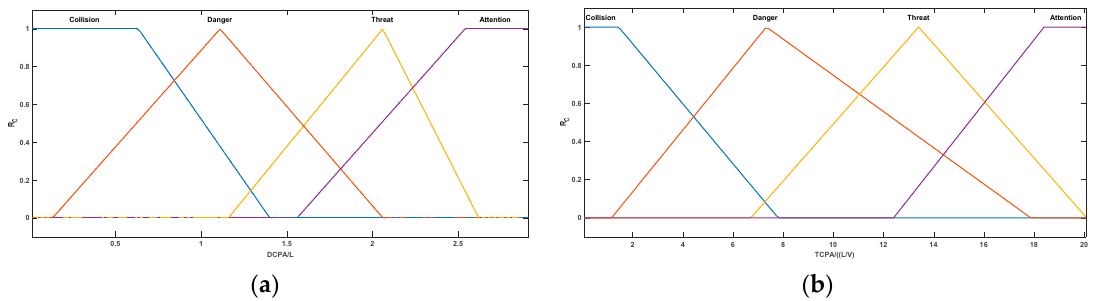
Figure 5. Membership function of the Type-1 Fuzzy Inference System based on Near-Collision (T1FIS-